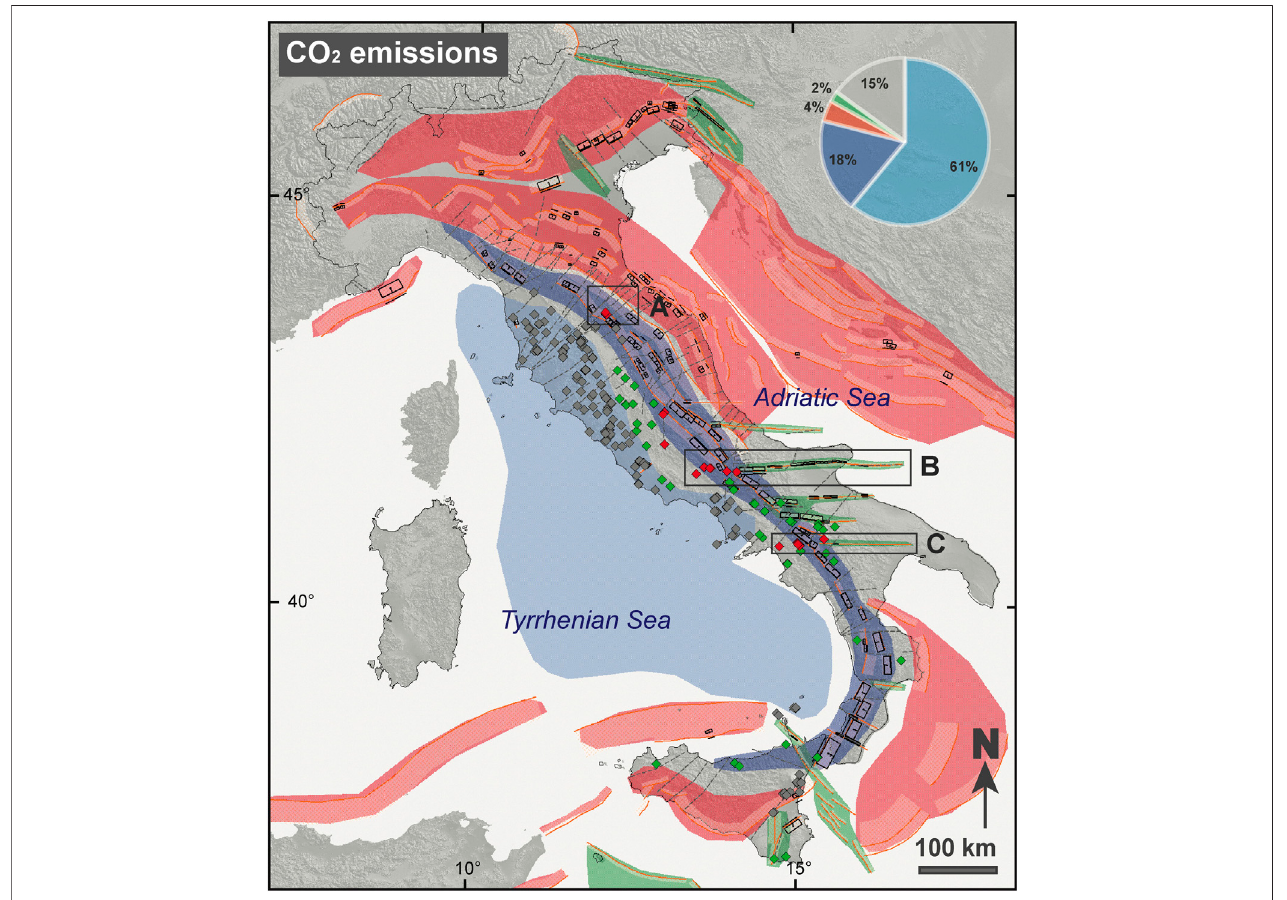
FIGURE 5 | Distribution of CO 2 emissions (see CO 2 Emissions , CO 2 Emissions and CO 2 Emissions: Combined Evidence for Carbonate Dissolution and Mantle Degassing Sections). Tectonic domains, seismogenic sources and transverse lineaments are shown as in Figure 2 . Removed datapoints are shown in grey. Selected datapoints are shown in red if they are individually discussed in the text, otherwise in white. The areas marked with A, B and C are discussed in Test Case 1: Central-Northern Apennines , Test Case 2: Central-Southern Apennines and Test Case 3: Southern Apennines Sections, respectively. The pie chart shows the distribution of CO 2 emissions in the different active tectonic domains (see Table 1 ). Notice that as many as 61% of the CO 2 emissions fall in the area of rifting and mantle upwelling.